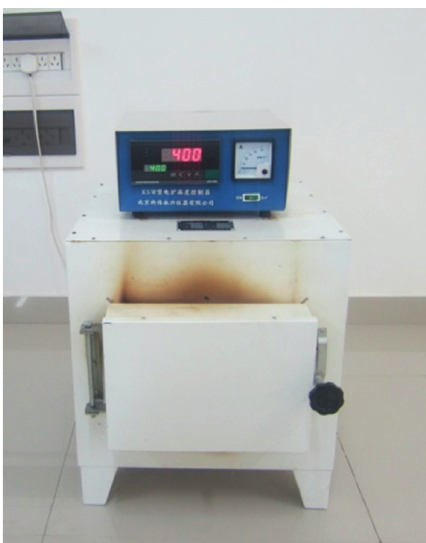
Figure 1: Box-type resistance furnace.